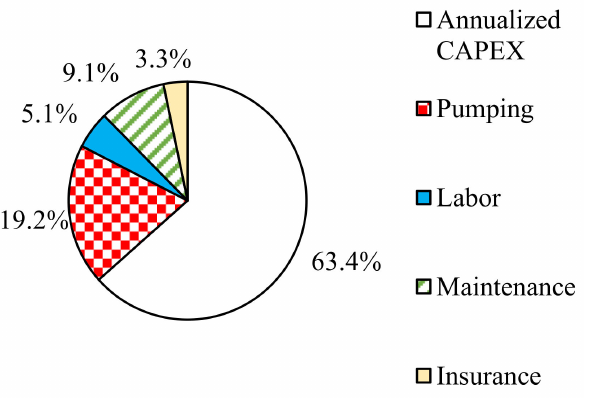
Figure 5. Average structure of operational costs and average annualized capital costs for the reference